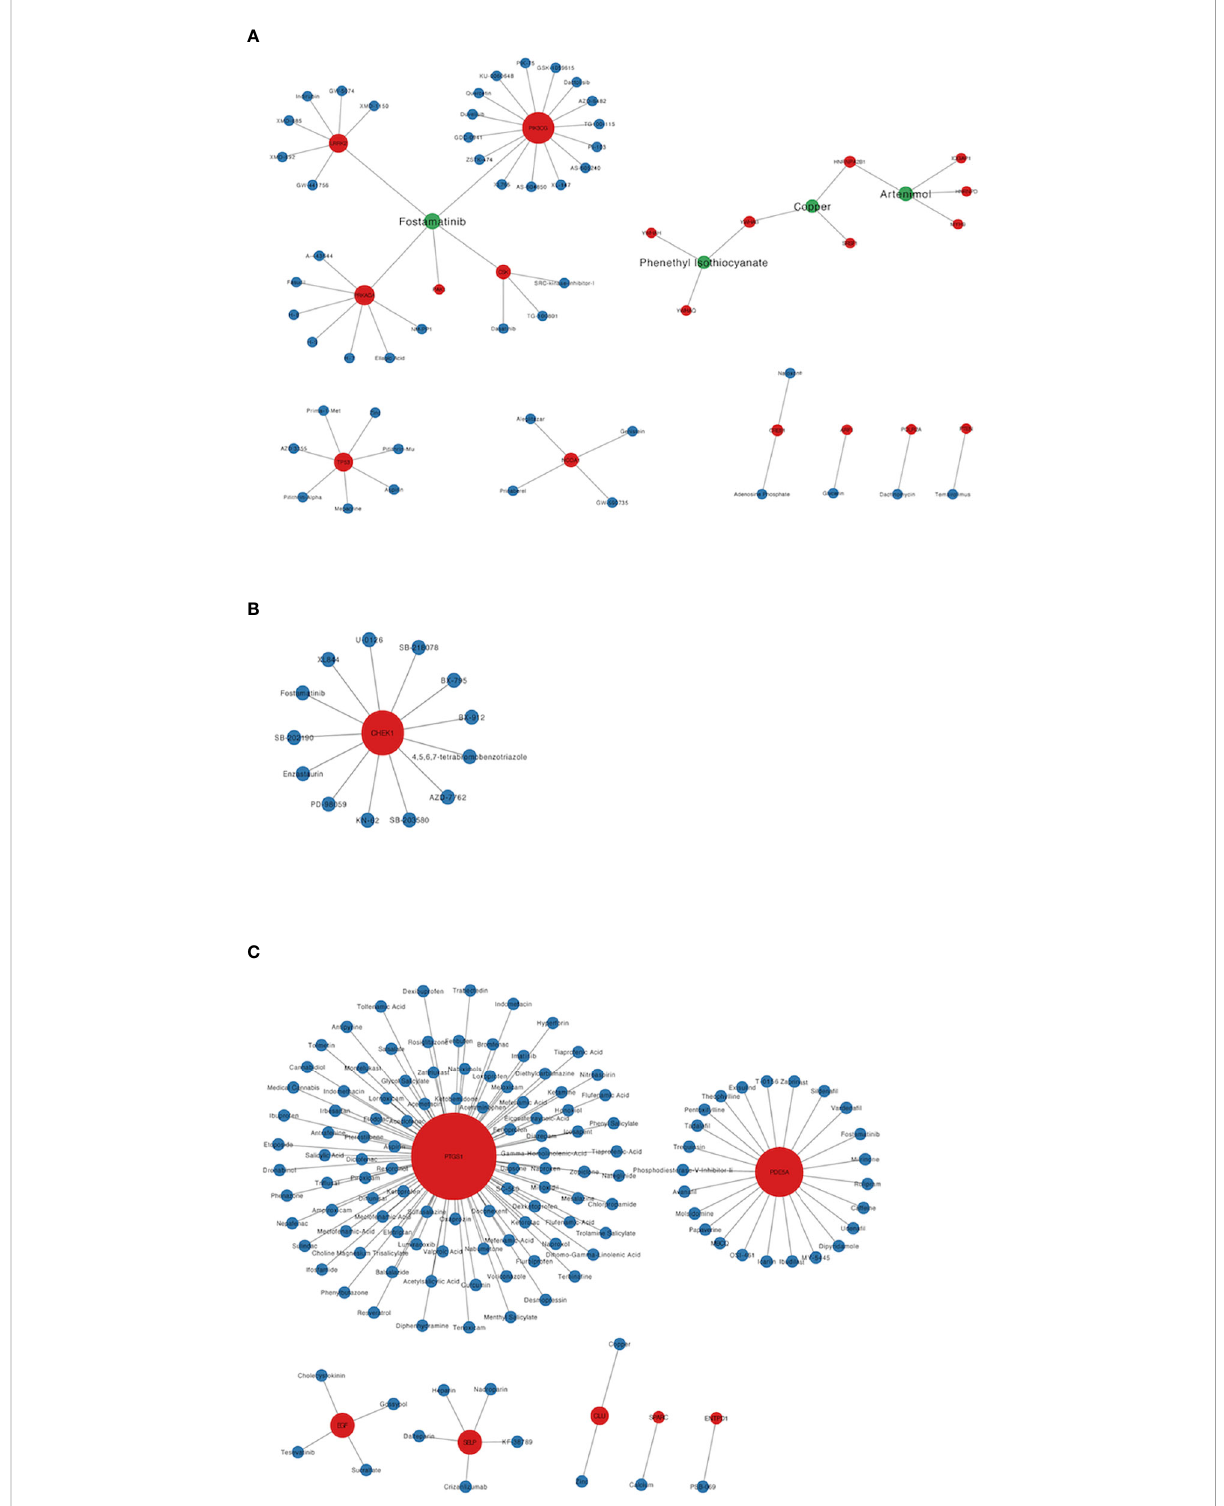
FIGURE 4 Candidate drugs targeting hub target genes were identi fi ed based on the CMap database and Drugbank database. Red nodes represent hub target genes, blue nodes represent candidate drugs targeting hub target genes, and green nodes represent candidate drugs targeting 2 or more than 2 hub target genes. (A) The candidate drugs targeting hub target genes of CD4+ T cells in MS patients treated with Fingolimod. (B) The candidate drugs targeting hub target genes of pDCs in MS patients treated with IFN- b . (C) The candidate drugs targeting hub target genes of PBMC in MS patients treated with IFN- b